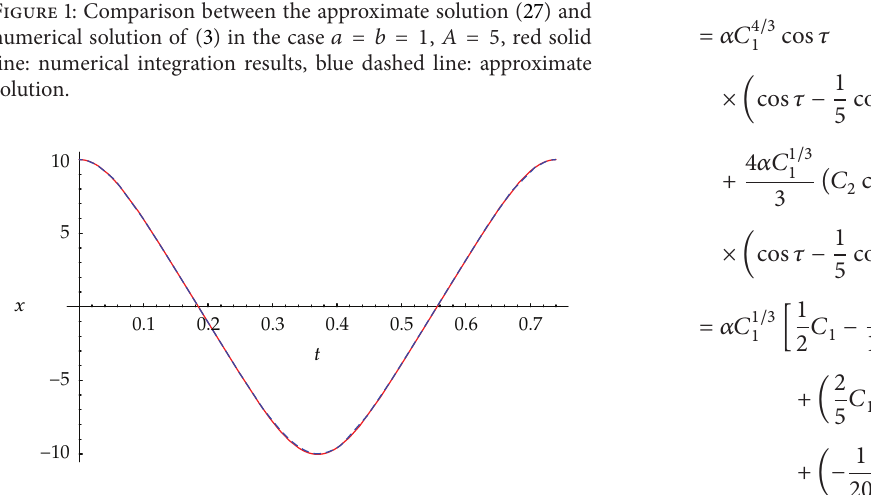
Figure 2: Comparison between the approximate solution (29) and numerical solution of (3) in the case 𝑎 = 𝑏 = 1 , 𝐴 = 10 , red solid line: numerical integration results, blue dashed line: approximate